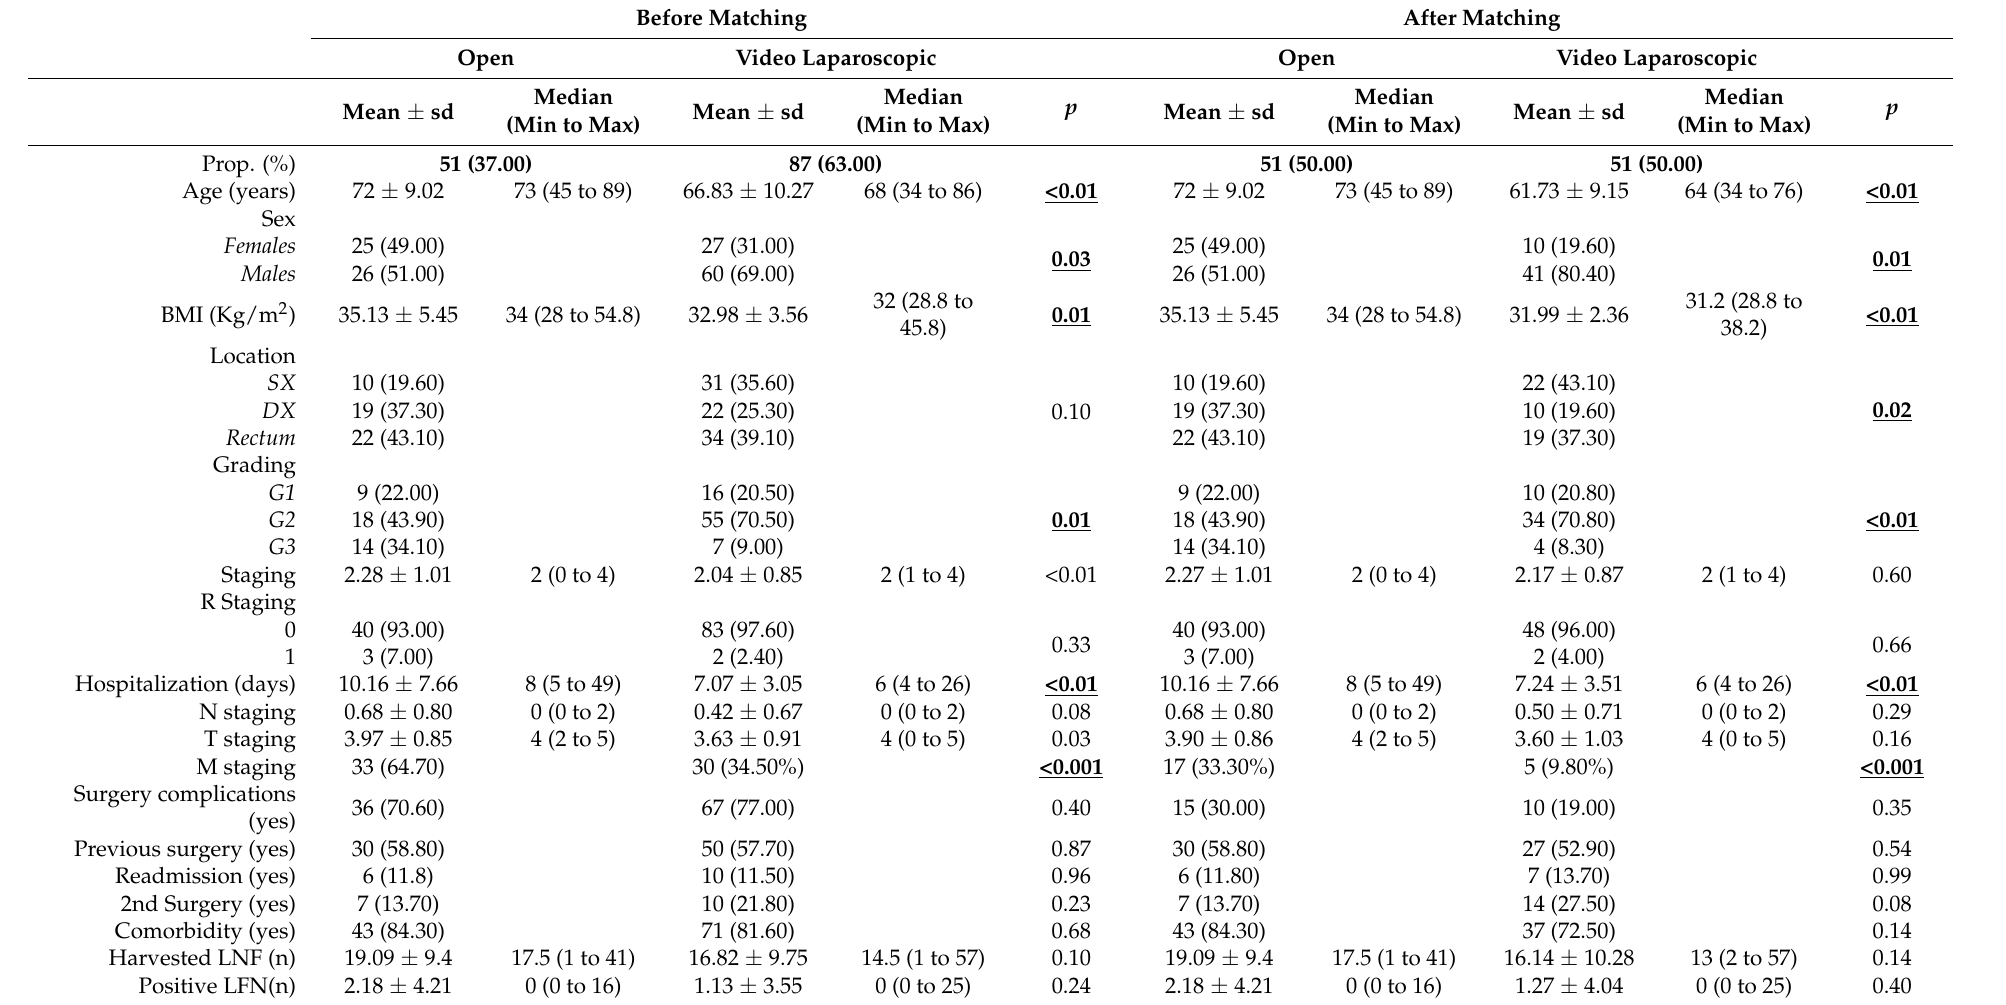
Table 1. Description of the whole sample according to the type of treatment, before and after